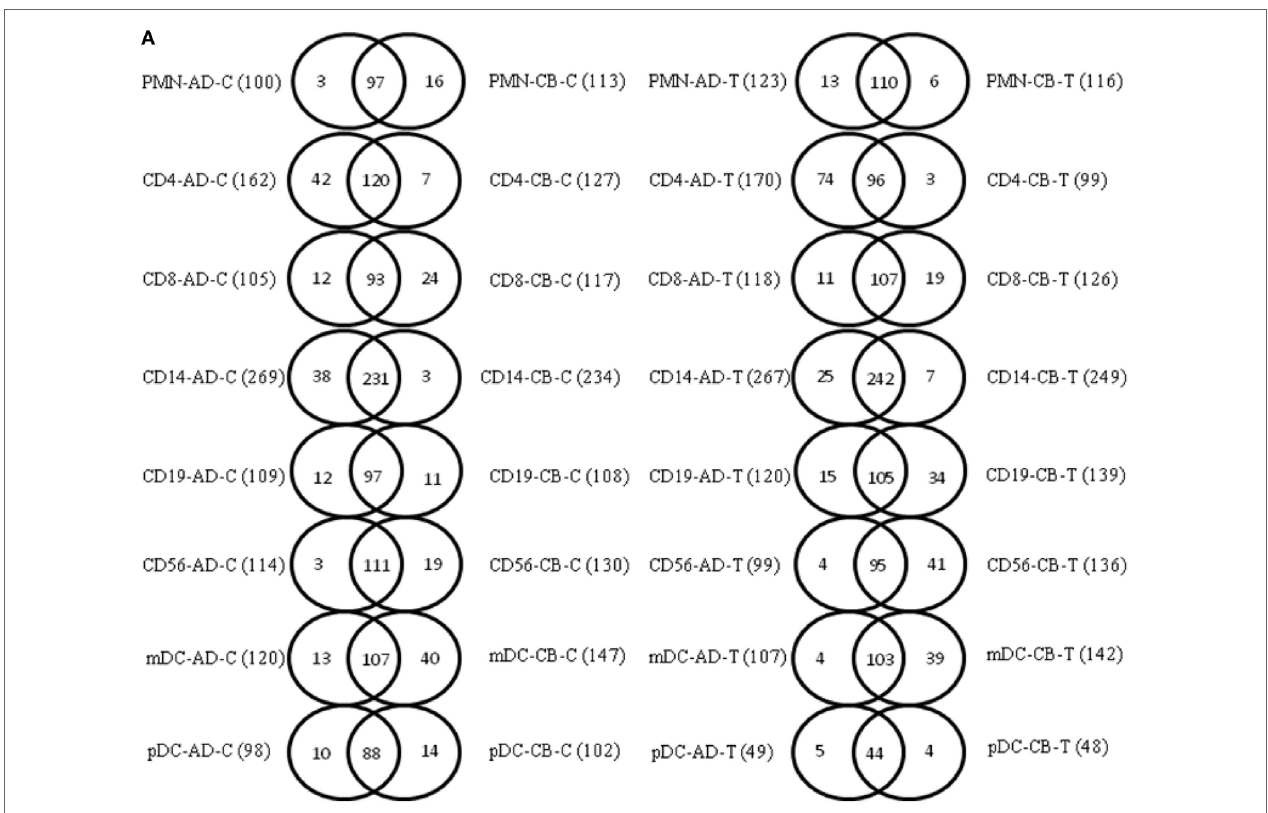
FigUre 2 | common and unique microrna (mirna) transcripts exist in adult and neonatal leukocyte subsets